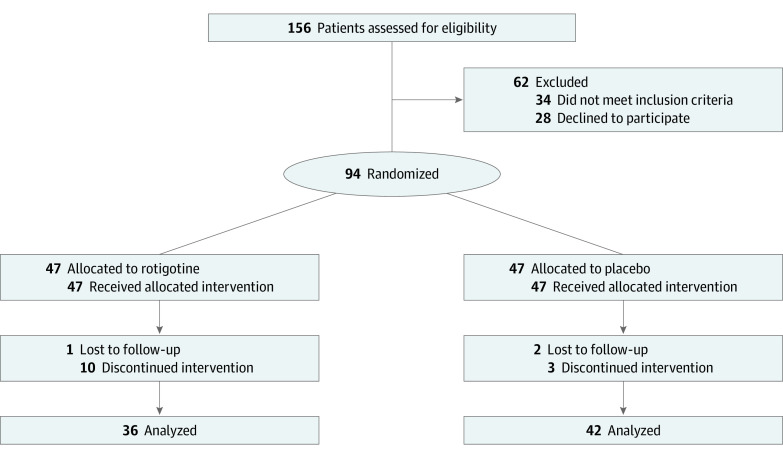
Study Flowchart